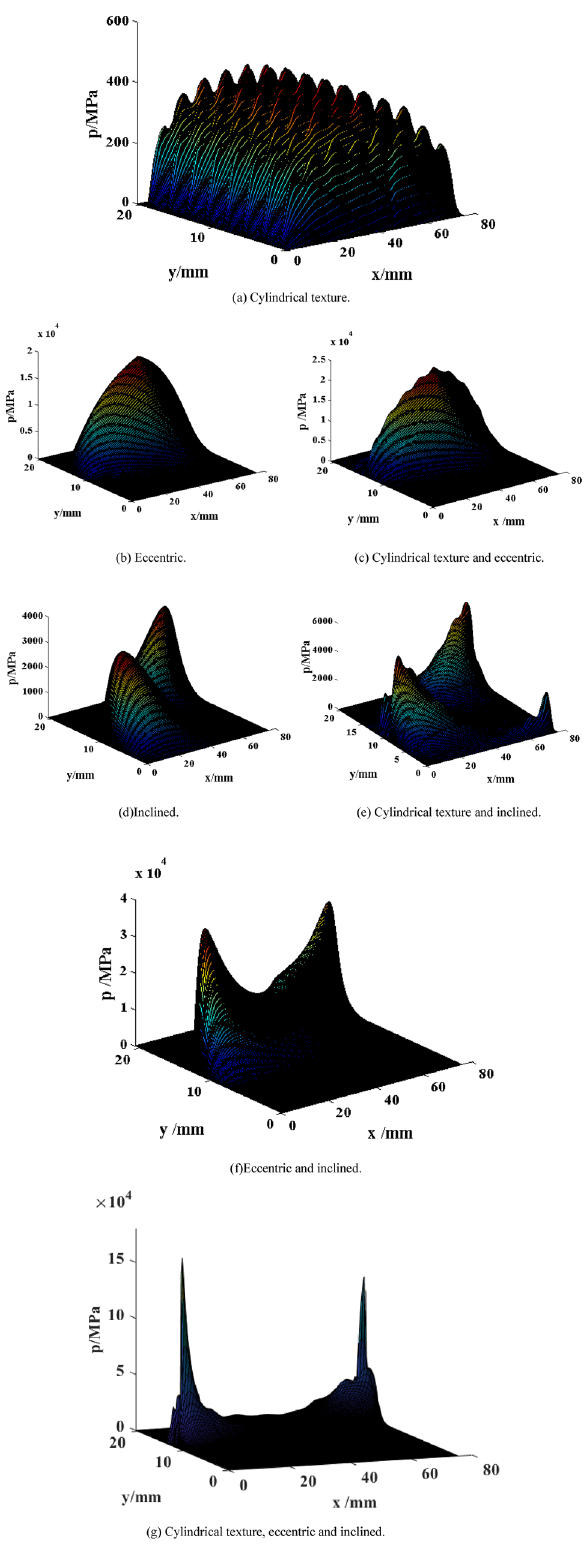
Figure 6. Distribution of pressure on the outer surface of the piston under different